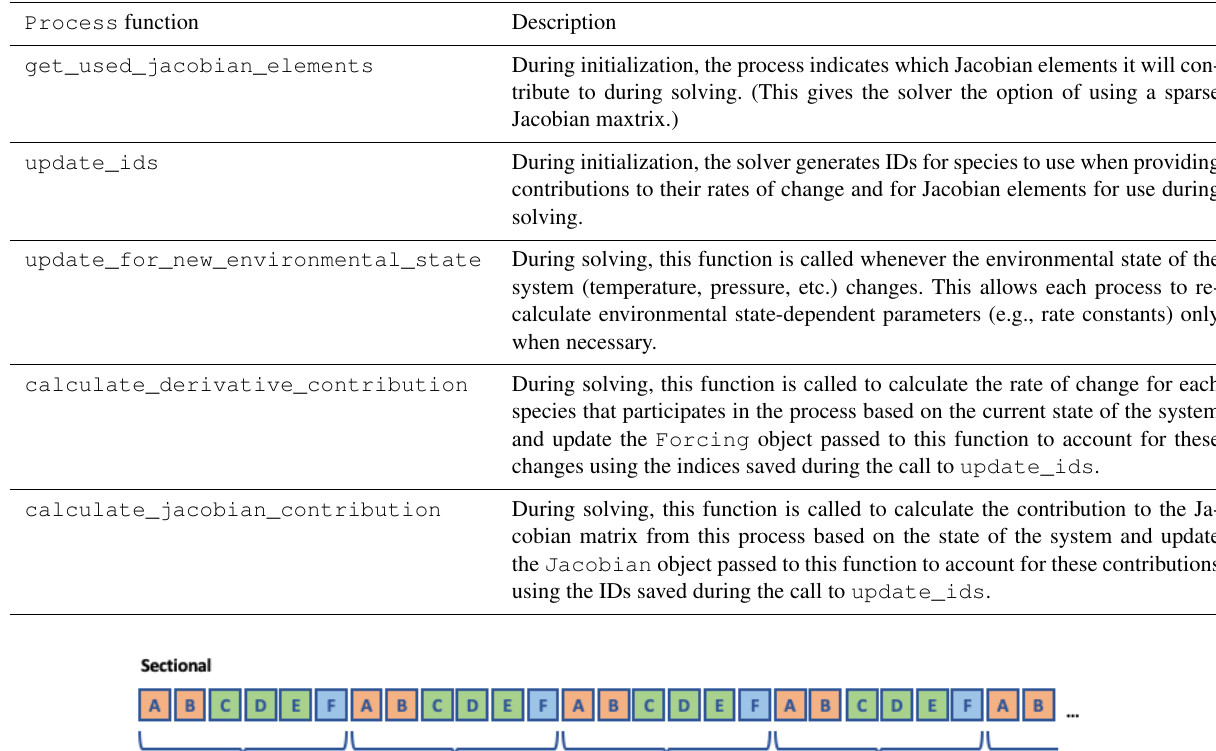
Table 1. Functions of the Process base class and its subclasses.